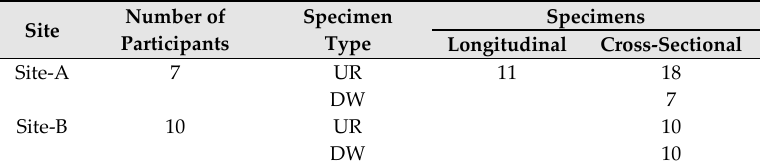
Table 1. Participants recruitment and specimen collection plan at Site A and B.